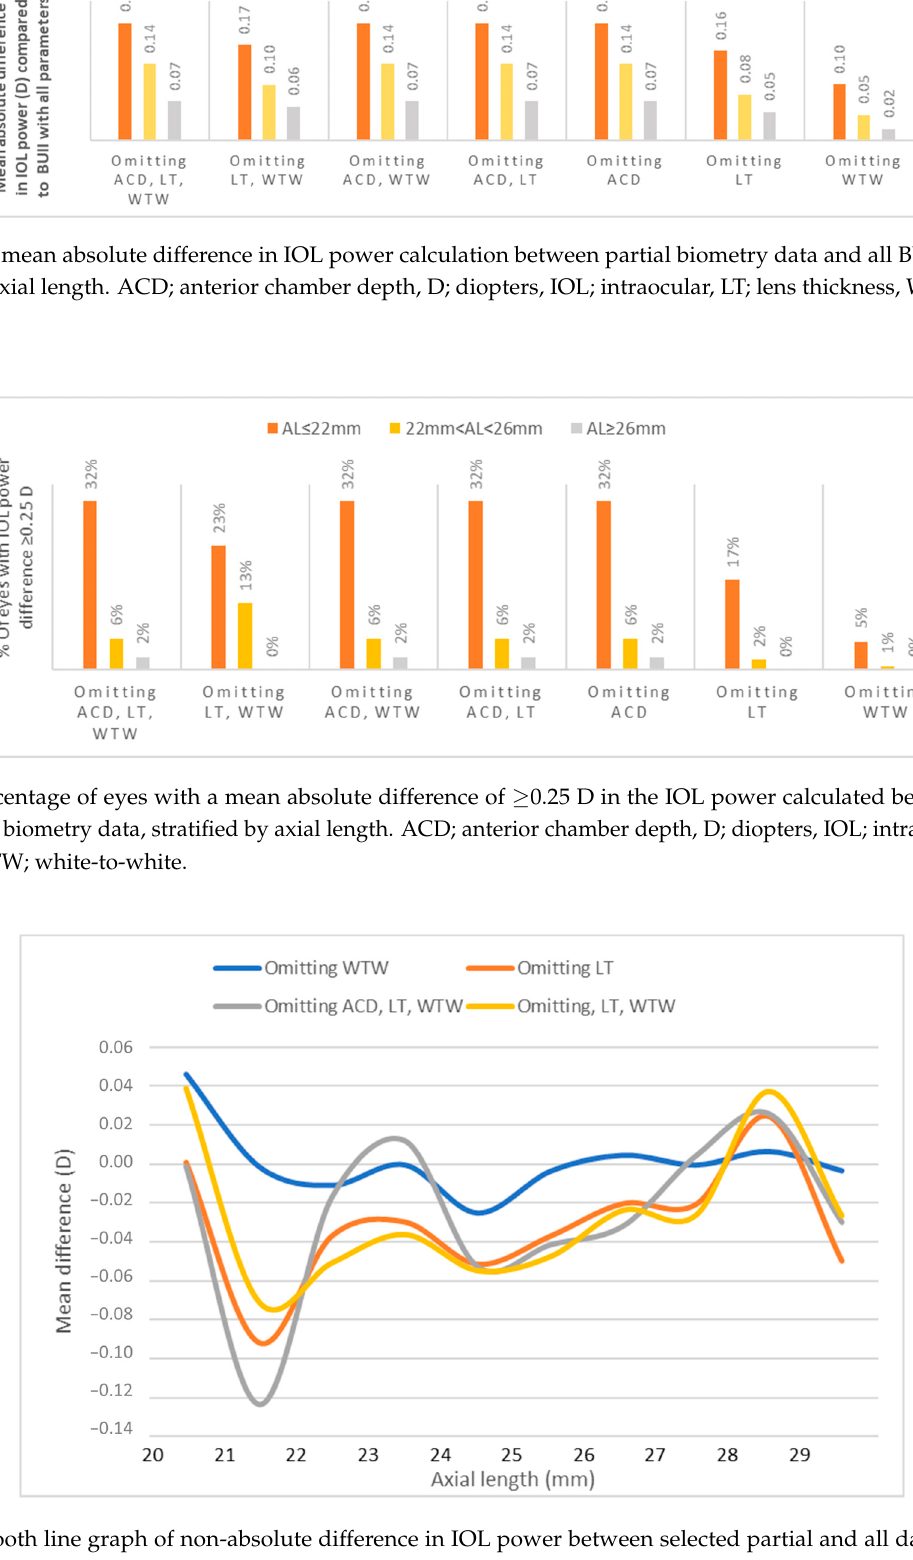
Figure 4. Smooth line graph of non-absolute difference in IOL power between selected partial and all data biometry in relation to axial length. ACD; anterior chamber depth, D; diopters, IOL; intraocular, LT; lens thickness, WTW; white-to-white.